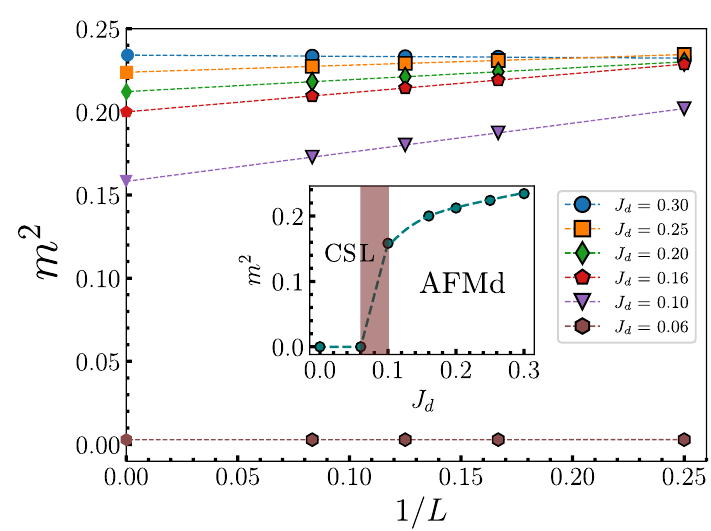
Figure 8: Finite-size scaling for the magnetic order parameter as a function of 1 / L = − 0.01, J = 1, and several values of J for J . Inset: Extrapolation of m 2 to the χ d 1 thermodynamic limit. m 2 = ( > ) 0 corresponds to the CSL (AFMd) phase. The colored region indicates the numerical uncertainty in the location of the phase transition.